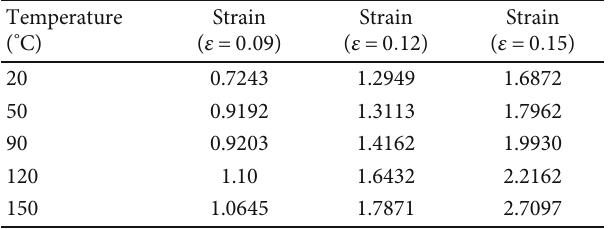
Table 5: Damage variables of salt rock at di ff erent temperatures. Table 6: Crack density parameters of salt rock at di ff erent temperatures.